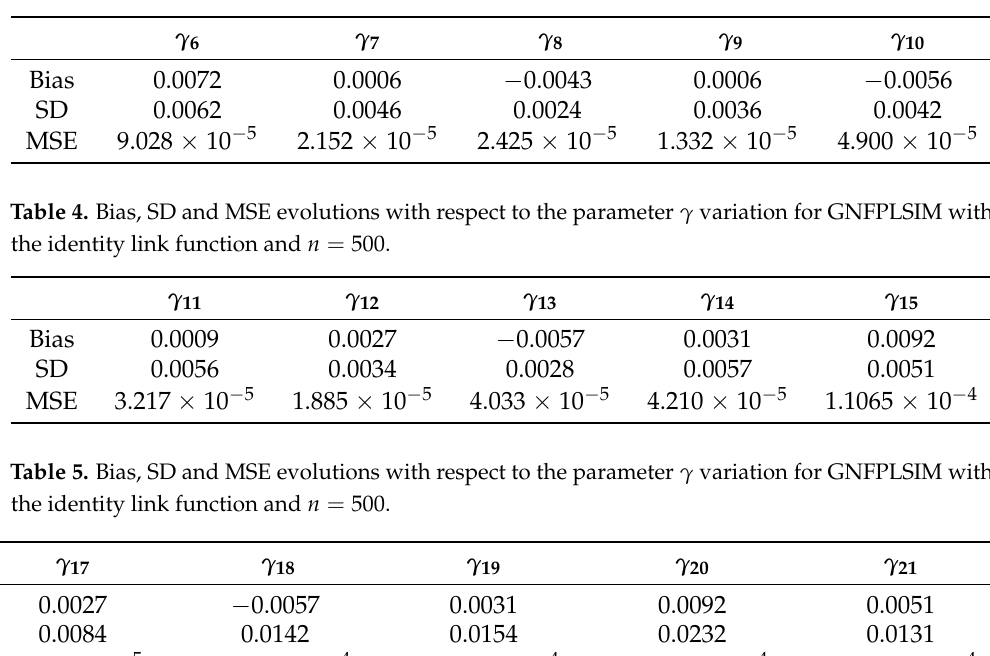
Table 3. Bias, SD and MSE evolutions with respect to the parameter γ variation for GNFPLSIM with the identity link function and n = 500.